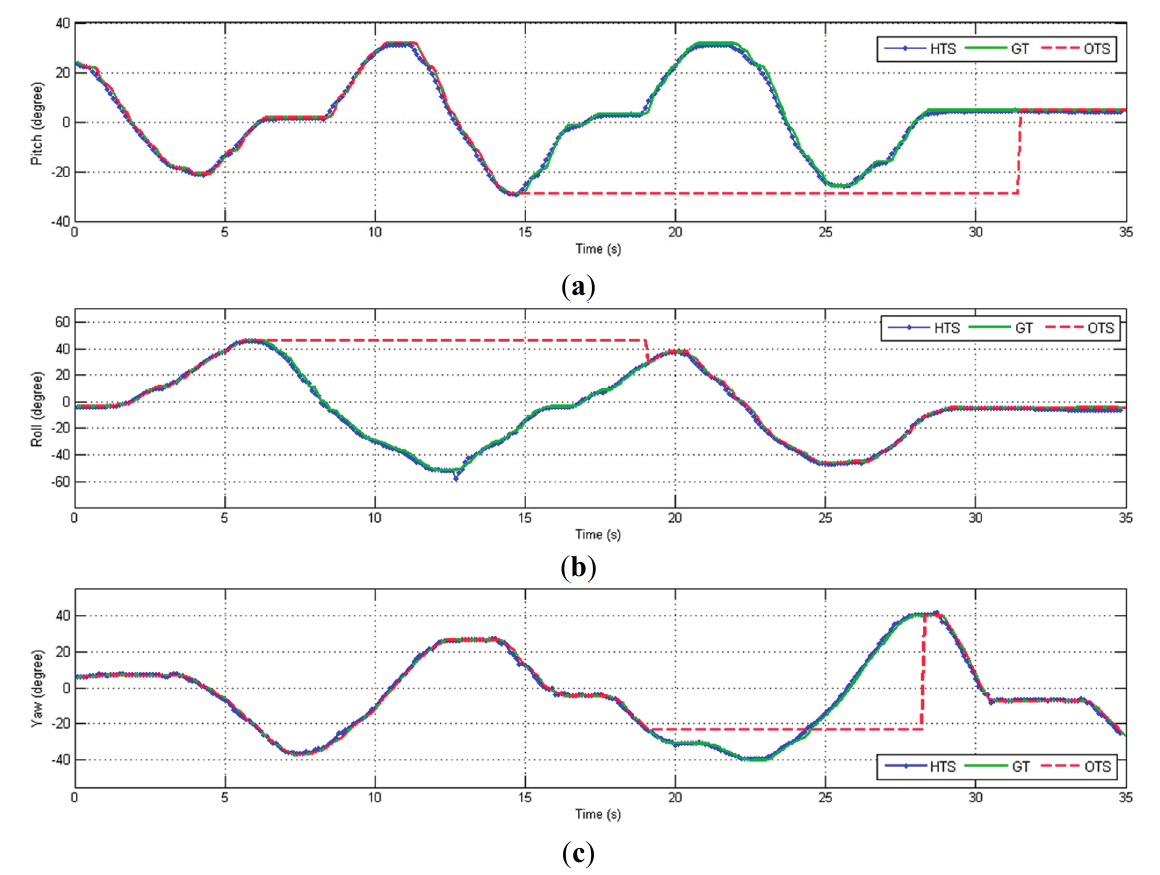
Figure 11. Orientation (degrees) in three-axes versus time, including cases of partial OTS occlusion (dashed red lines). ( a ) Pitch; ( b ) Roll; ( c )